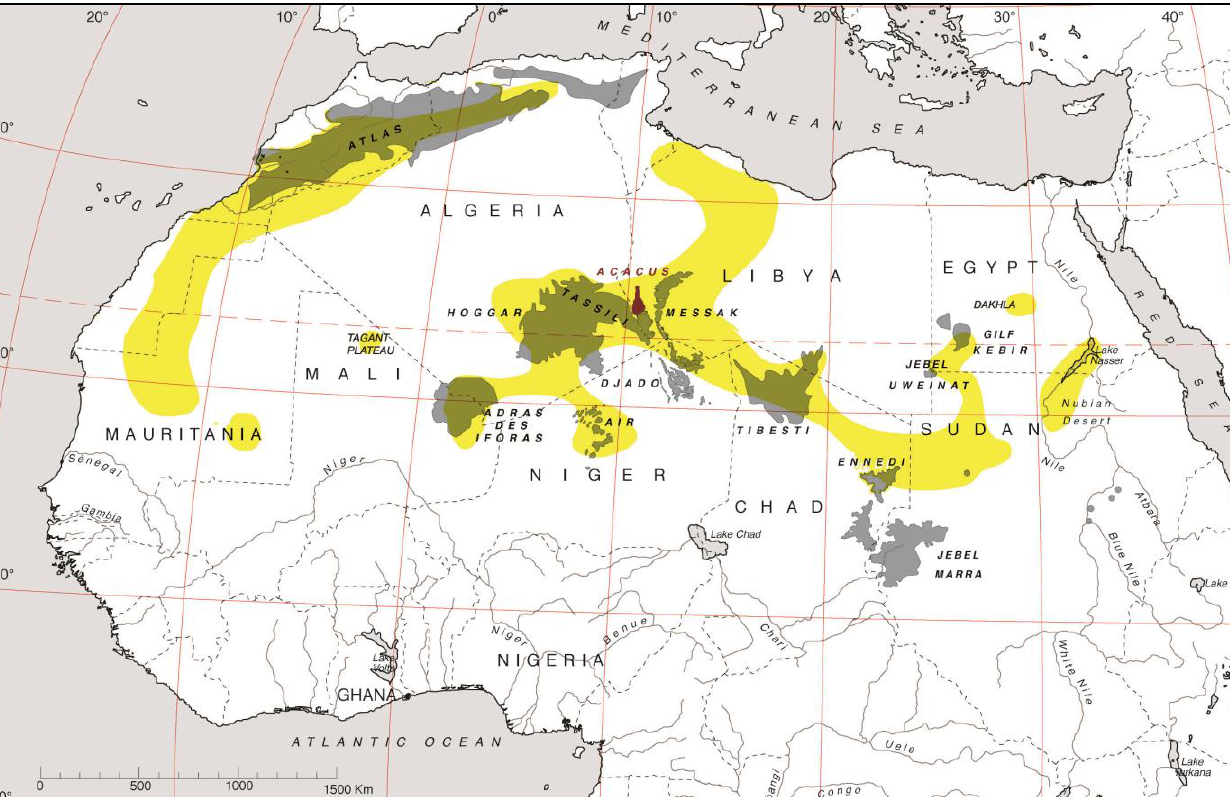
Figure 1. Map of the Sahara showing the main mountain systems and the major rock art concentrations